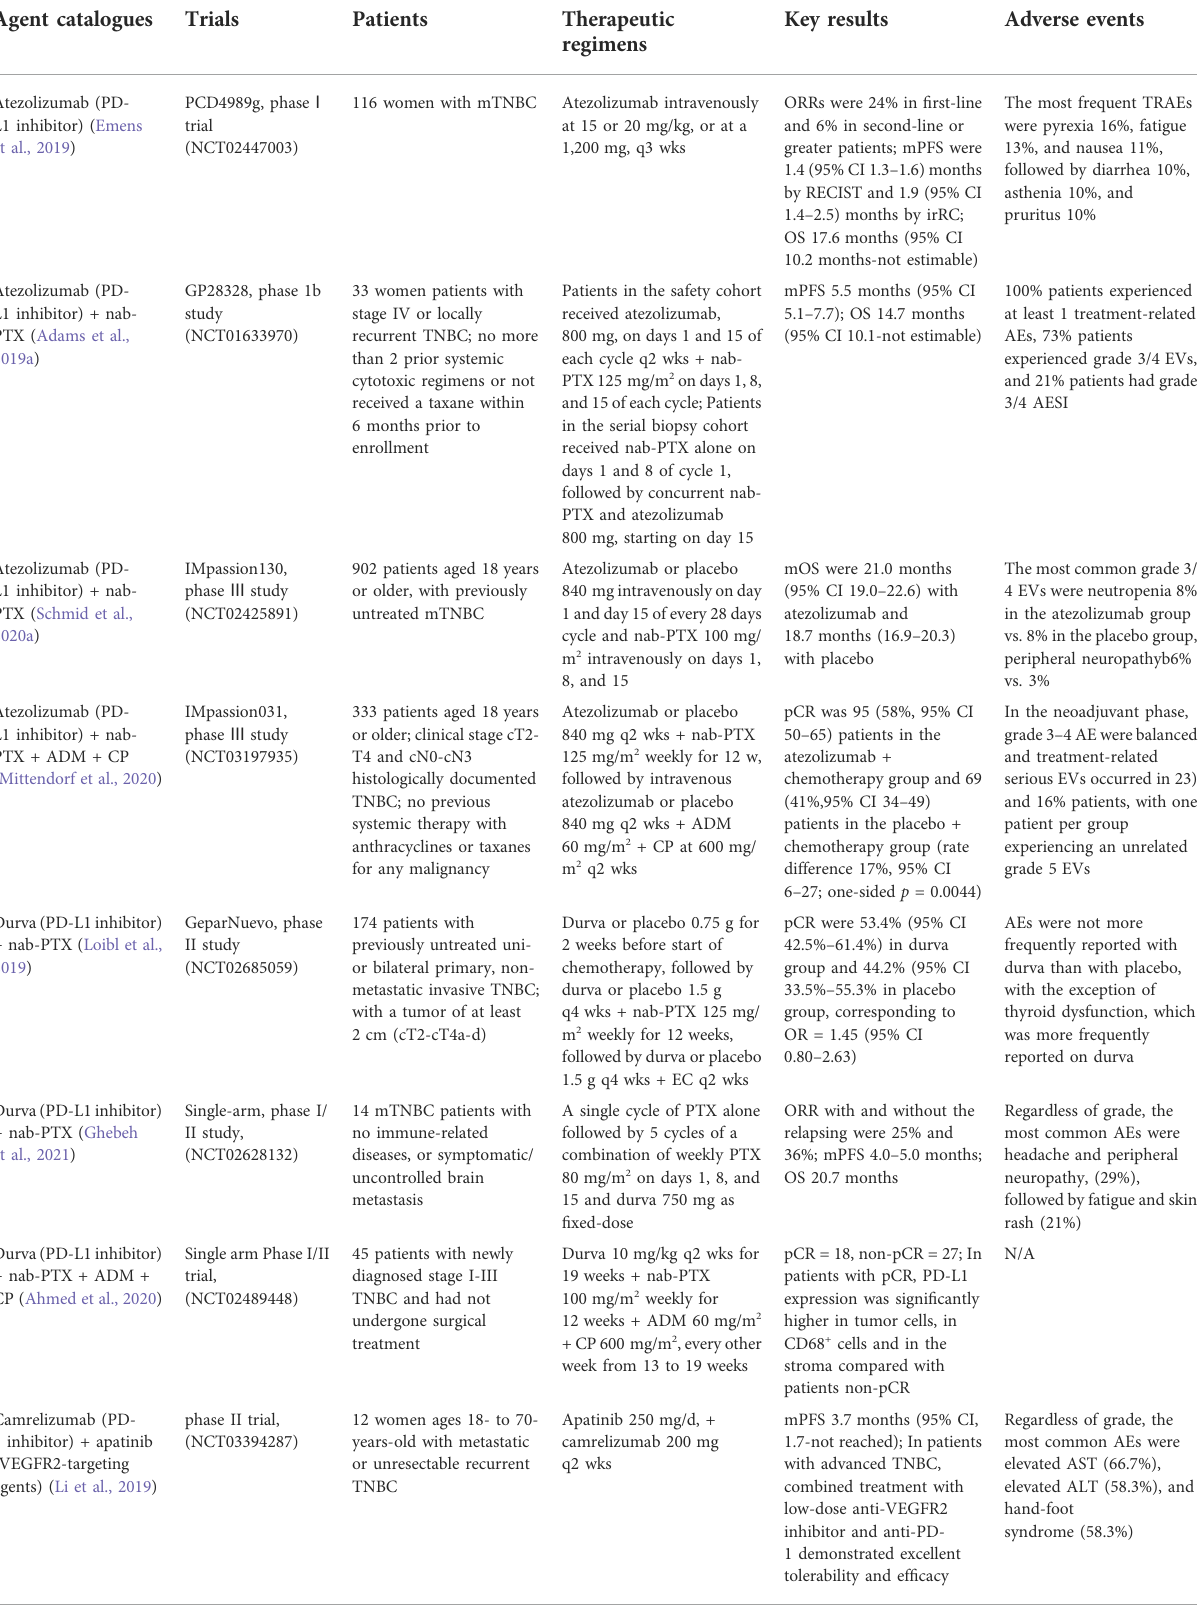
TABLE 1 Current PD-L1/PD-1 inhibior trials in TNBC